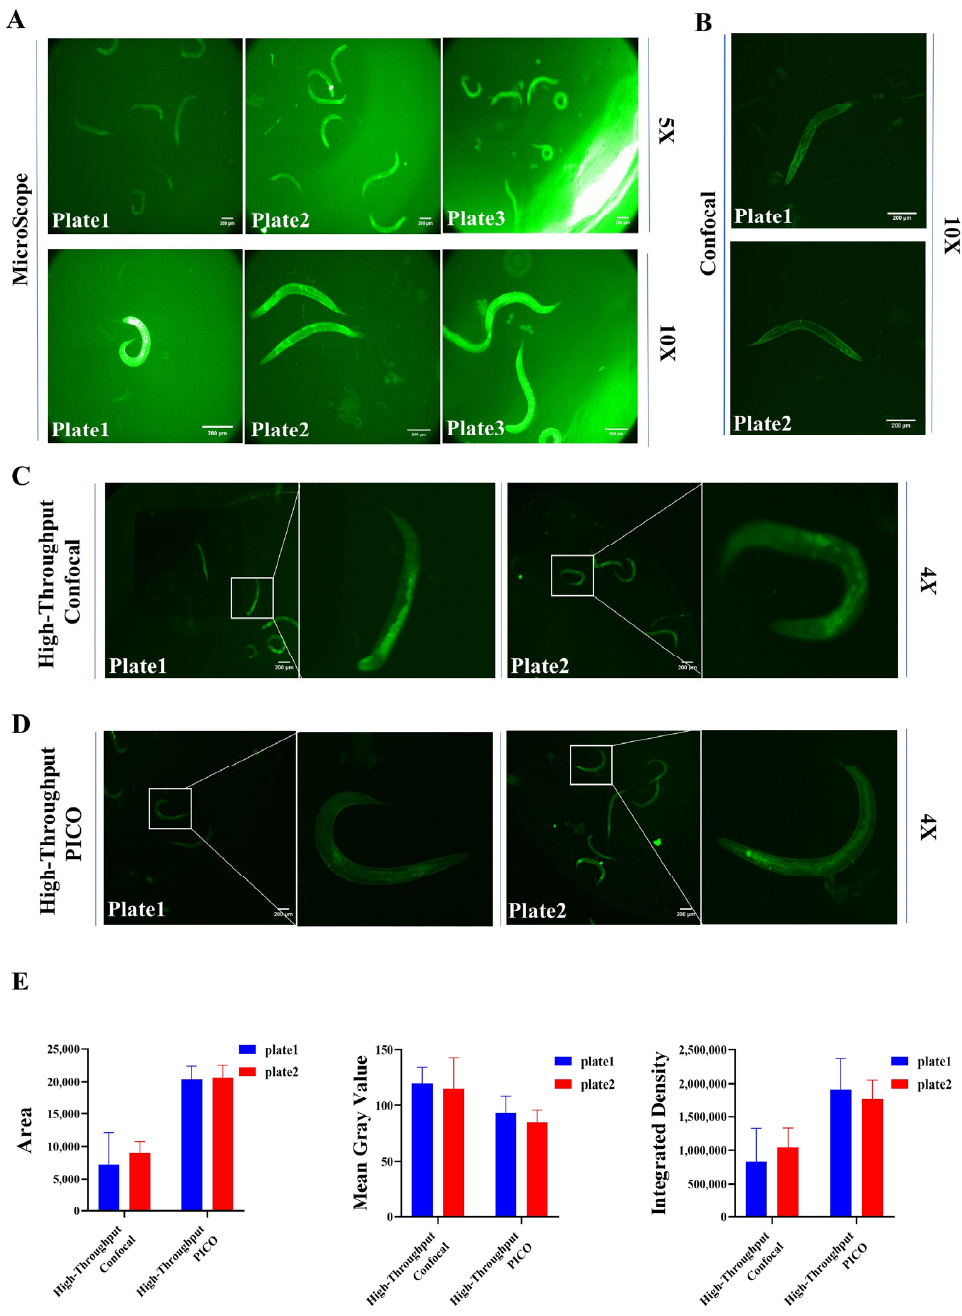
Figure 2. Optimization of imaging conditions ( A ) Image sampling with Microscope at different plate types and magnifications (Scale bars, 10 μ m); ( B ) Image sampling with Confocal at different plate types and magnifications (Scale bars, 10 μ m); ( C ) Image sampling with High ‐ Throughput Confocal at different plate types and magnifications (Scale bars, 10 μ m); ( D ) Image sampling with High ‐ Throughput PICO at different plate types and magnifications (Scale bars, 10 μ m); ( E ) Analysis of single nematode related data, n = 3.